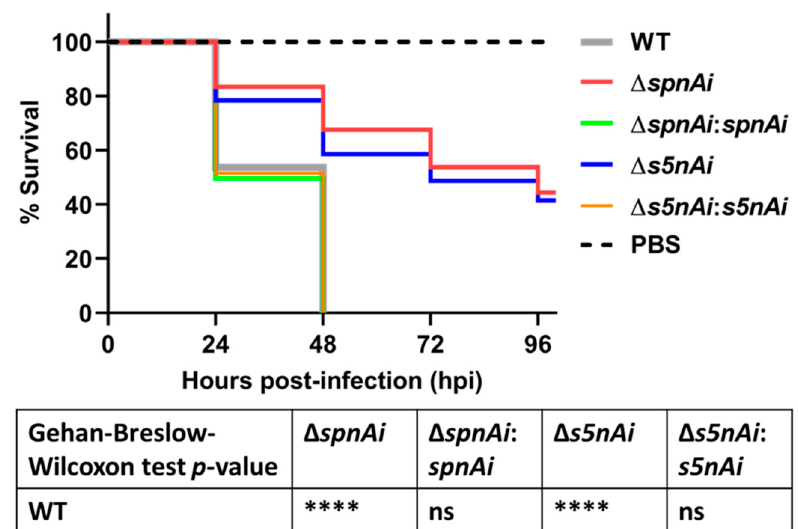
Figure 4. Survival analysis of zebrafish larvae infected with WT and mutant S. iniae strains. WT, ∆ spnAi , ∆ s5nAi and their complementation strains were each injected into 2 days post-fertilization (dpf) larvae (wild-type AB line). The survival of infected larvae was recorded over a 96 h-period. This data is the combined result from 3 independent experiments ( n = 35 per group in each experiment). ****, p < 0.0001; ns, not significant (as determined by the a Gehan–Breslow–Wilcoxon test).